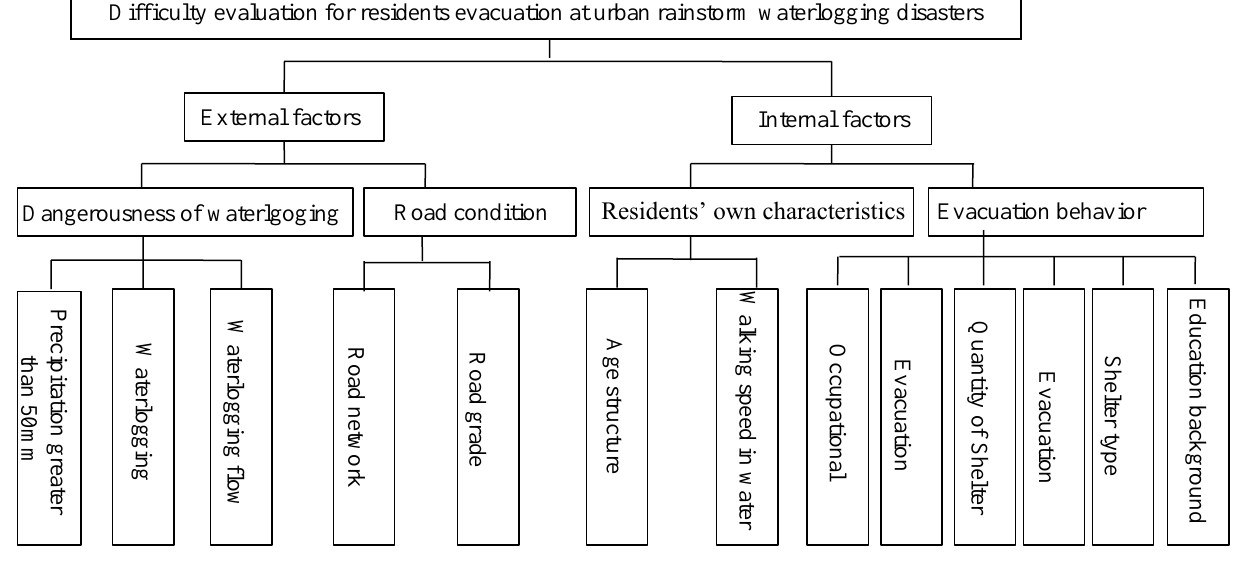
Figure 7. Conceptual framework for residents’ difficulty evacuation at urban rainstorm waterlogging